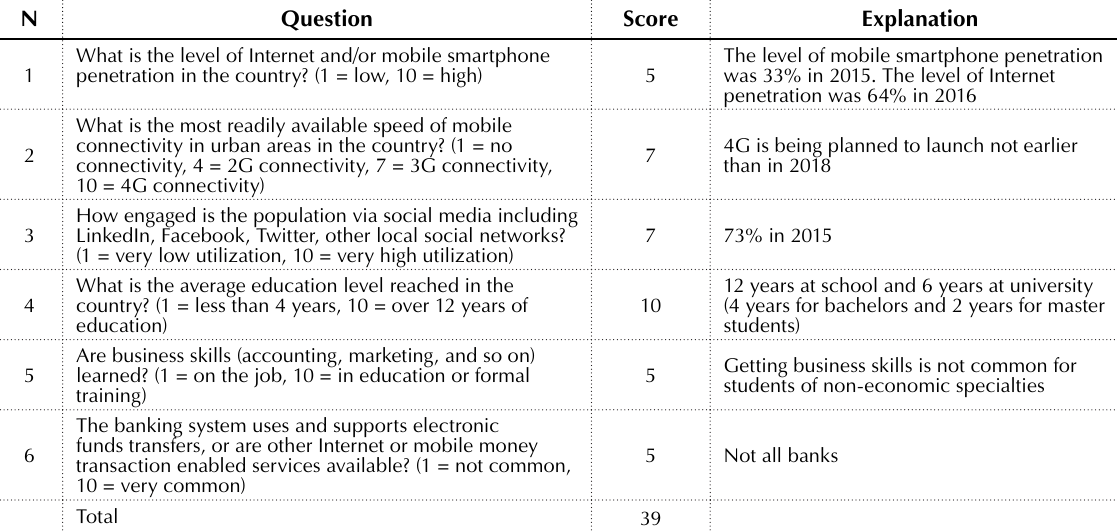
Table 3. Assessing a country’s readiness for crowdfunding: technology (A)